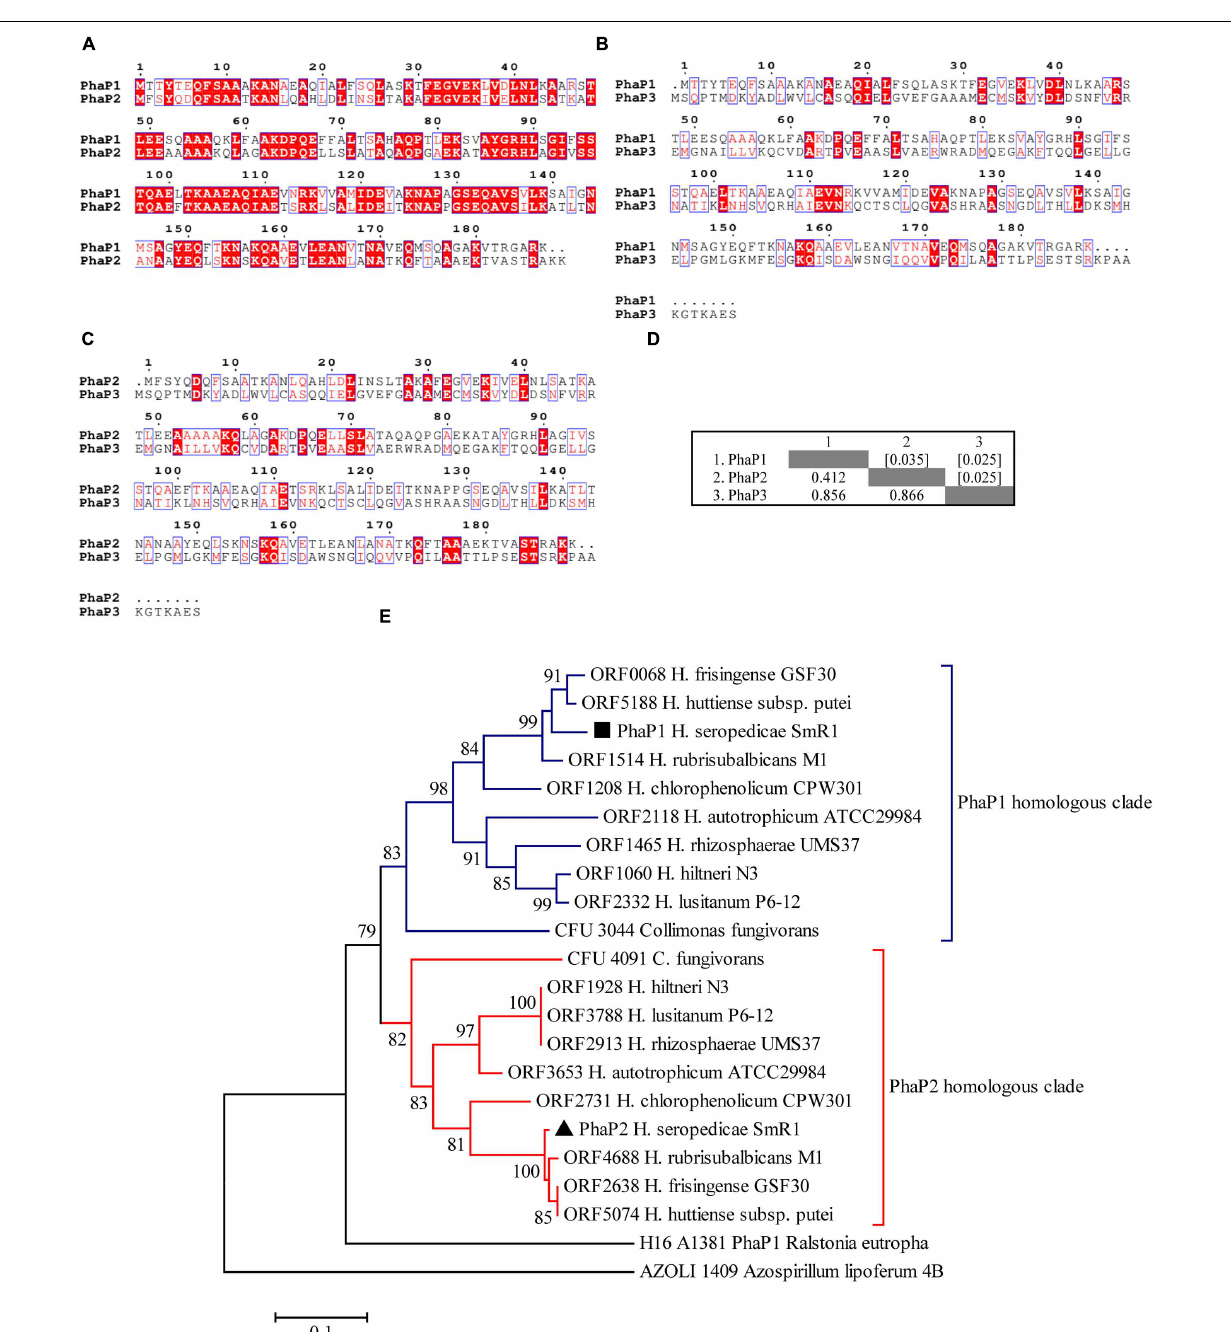
Frontiers in Microbiology |